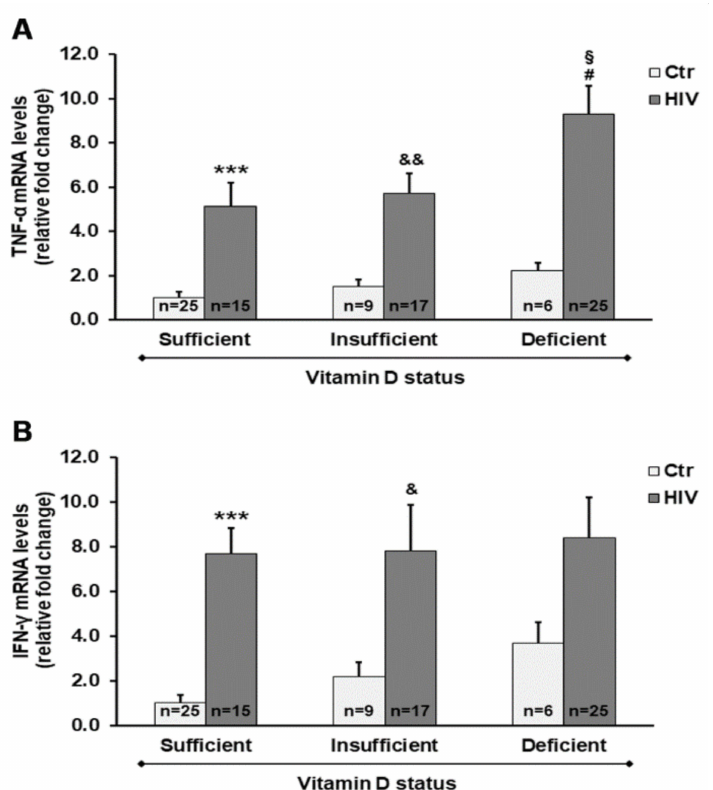
Figure 3. Gene expression of both tumor necrosis factor- α ( TNF- α ) ( A ) and interferon- γ ( IFN- γ ) ( B ) in PBMC from HIV + and healthy subjects. mRNA transcript levels were evaluated by real-time PCR. The results are expressed as mean ± SEM. *** p < 0.001 significant di ff erences in comparison to healthy subjects with su ffi cient 25(OH)D 3 levels; & p < 0.05 and && p < 0.01 significant di ff erences in comparison to healthy subjects with insu ffi cient 25(OH)D 3 levels; # p < 0.05 significant di ff erences in comparison to healthy subjects with deficient 25(OH)D 3 levels; § p < 0.05 significant di ff erence in comparison to HIV + subjects with su ffi cient 25(OH)D 3